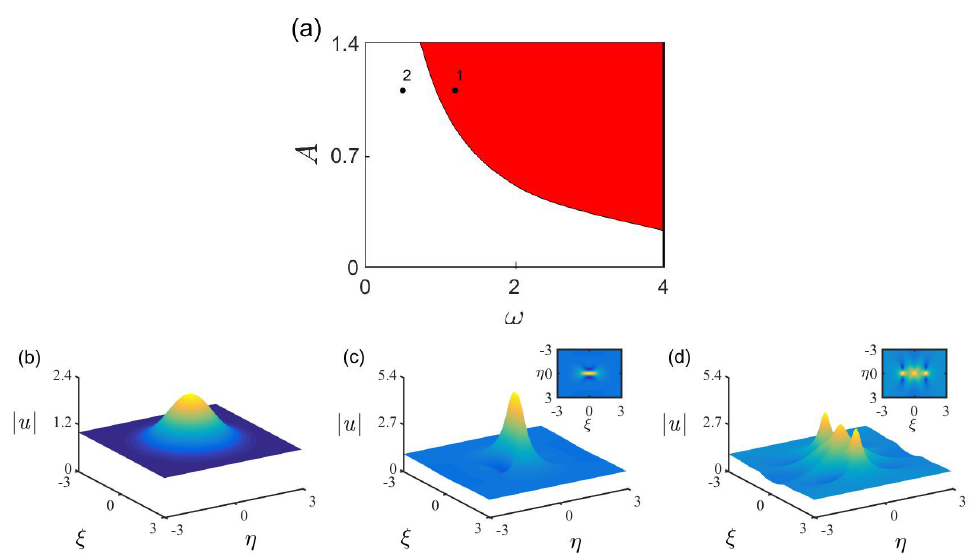
Figure 2. (Color online) ( a ) The phase transition regions of nonlinear modes as functions of amplitude ( A ) and width ( ω ) of the initial pulse when C = 1. According to above criteria about nonlinear modes, we found the red region containing point 1 is for high-dimensional rogue waves. ( b – d ) The profiles of nonlinear modes with different distance: s = 0, 0.72, and 1.63, respectively. Here, ω =